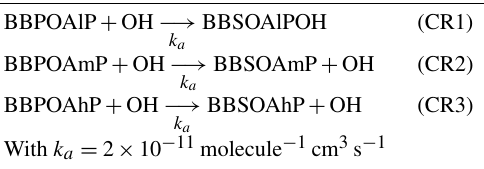
Table C1. Ageing mechanism of I/S/L-VOCs using Couvidat approach (Couvidat et al., 2012).